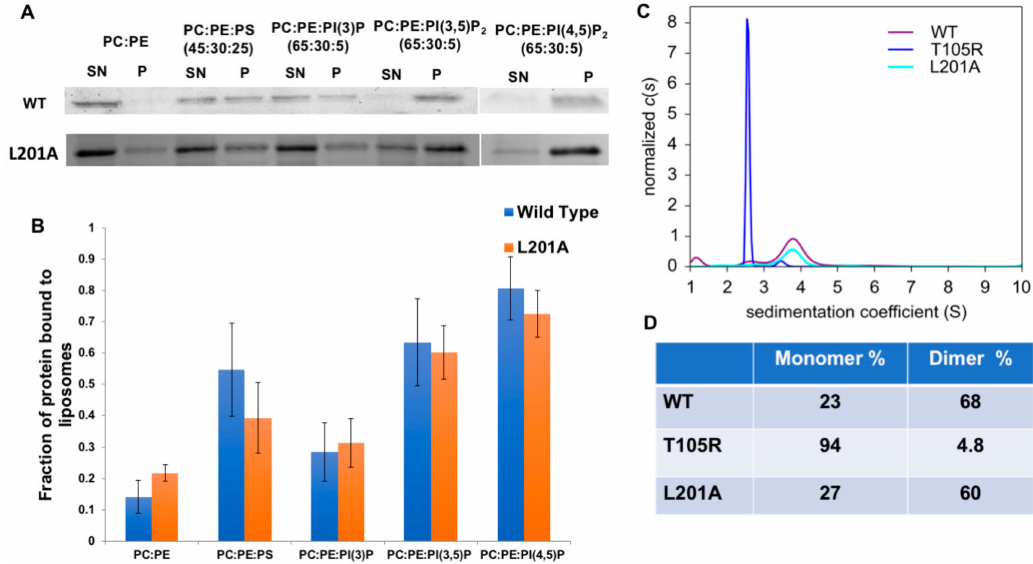
Figure 5. Biophysical properties of the L201A mutant are similar to WT mVP40 including anionic membrane binding properties and dimeric state in solution. ( A ) SDS-PAGE of supernatant (SN) and pellet (P) fractions collected from MLV sedimentation assays on lipid compositions and ratios appearing above the images for WT and L201A proteins. ( B ) Quantification of MLV sedimentation assays. The data represent the average of three sedimentation assays with error bars representing the standard error of the mean. ( C ) mVP40 protein size distribution was obtained through fitting data from sedimentation velocity experiments to continuous distribution c(s) Lamm equation model. ( D ) Monomer and dimer percentages of WT mVP40 (WT), T105R and L201A mutants obtained from sedimentation velocity